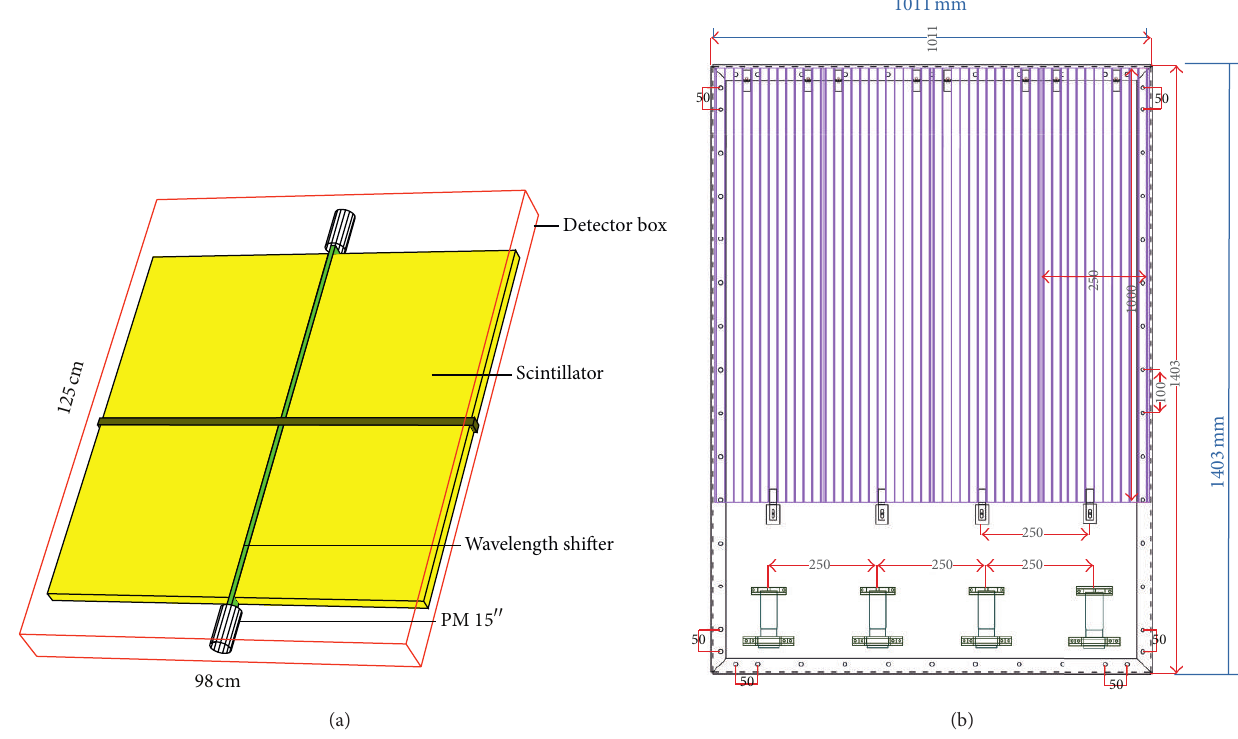
Figure 1: The detection module of (a) the first detector setup. Design of KASCADE [3]; (b) the new detector setup [5].